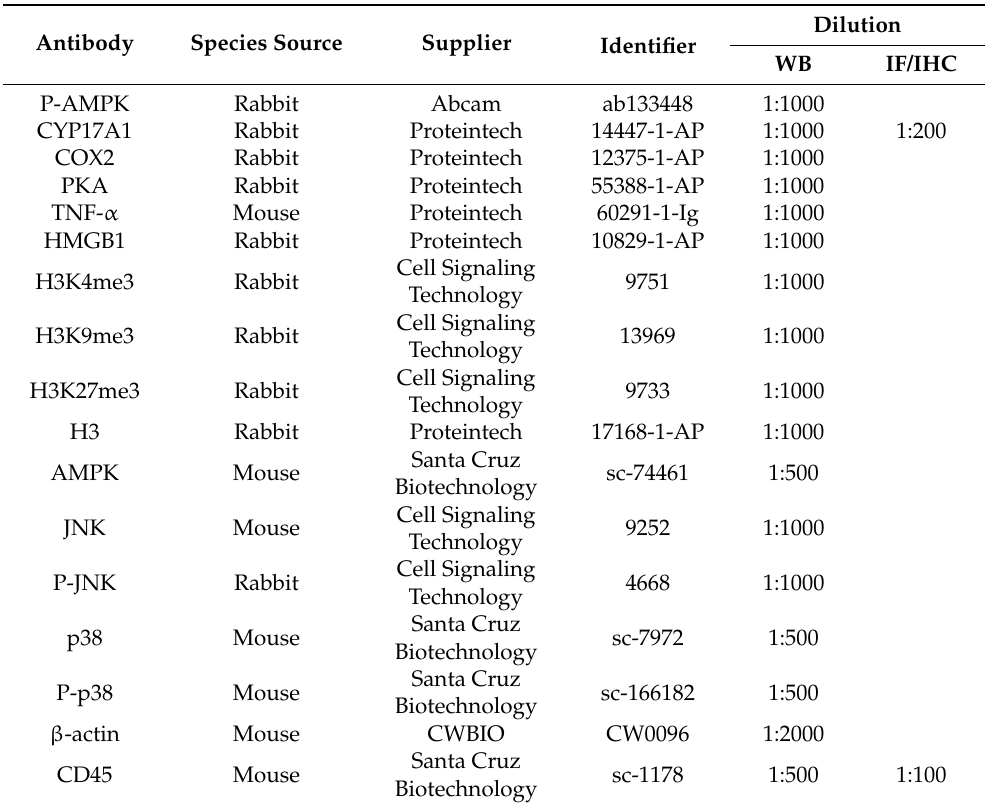
Table 2. The antibody